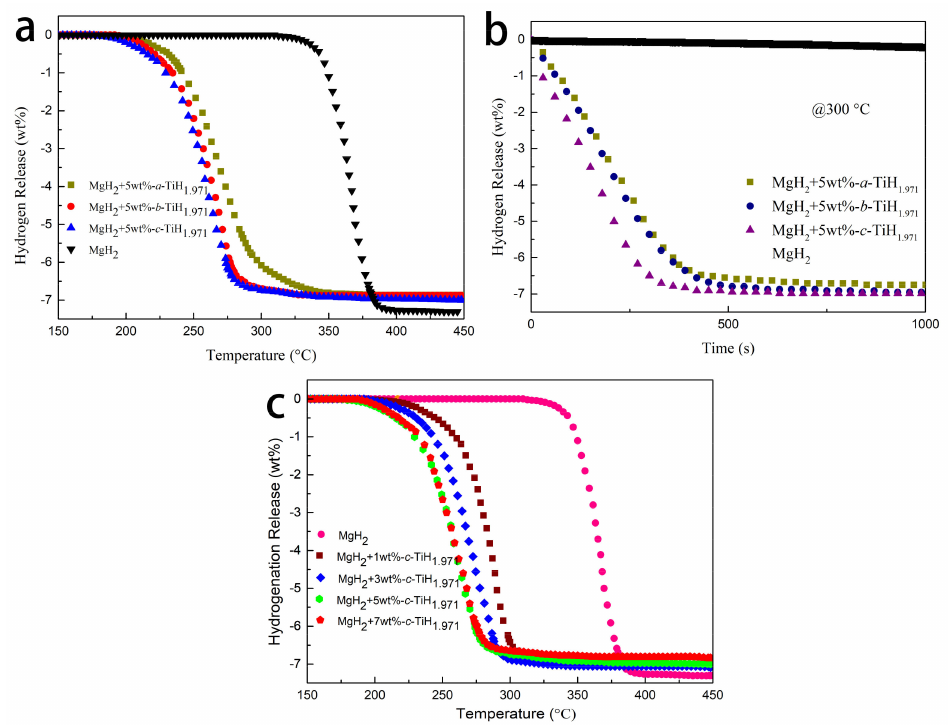
Figure 2. Non-isothermal desorption curves ( a ) of MgH 2 and MgH 2 + 5 wt%- x -TiH 1.971 ( x = a -30, b -45 and c -60) samples, isothermal desorption curves ( b ) of MgH 2 + 5 wt%- x -TiH 1.971 samples at 300 ◦ C, non-isothermal desorption curves ( c ) of MgH 2 and MgH 2 + y wt%- c -TiH 1.971 ( y = 1, 3, 5, and 7)